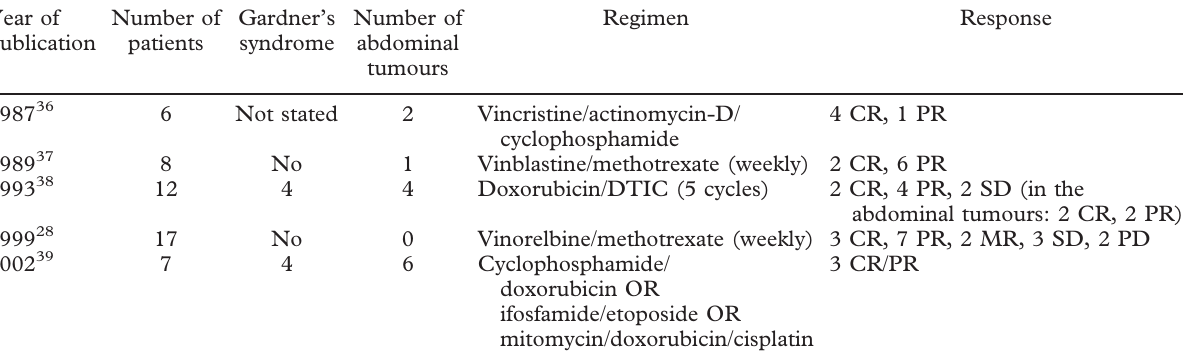
Table 2. Cytotoxic chemotherapy regimens used over the years as published in the literature (CR, complete response; PR, partial response; MR, minor response; SD, stable disease; PD, progressive disease.) Year of Number of publication